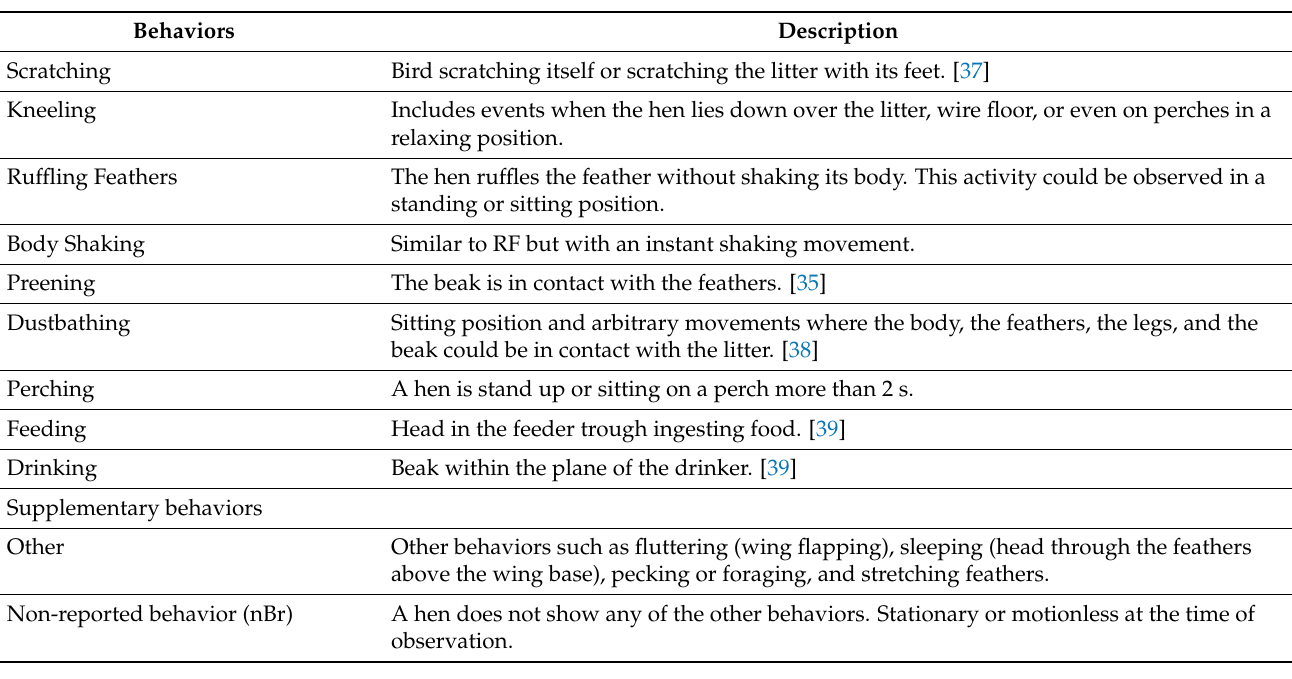
Table 2. Laying hen behaviors observed inside all experimental CFS.